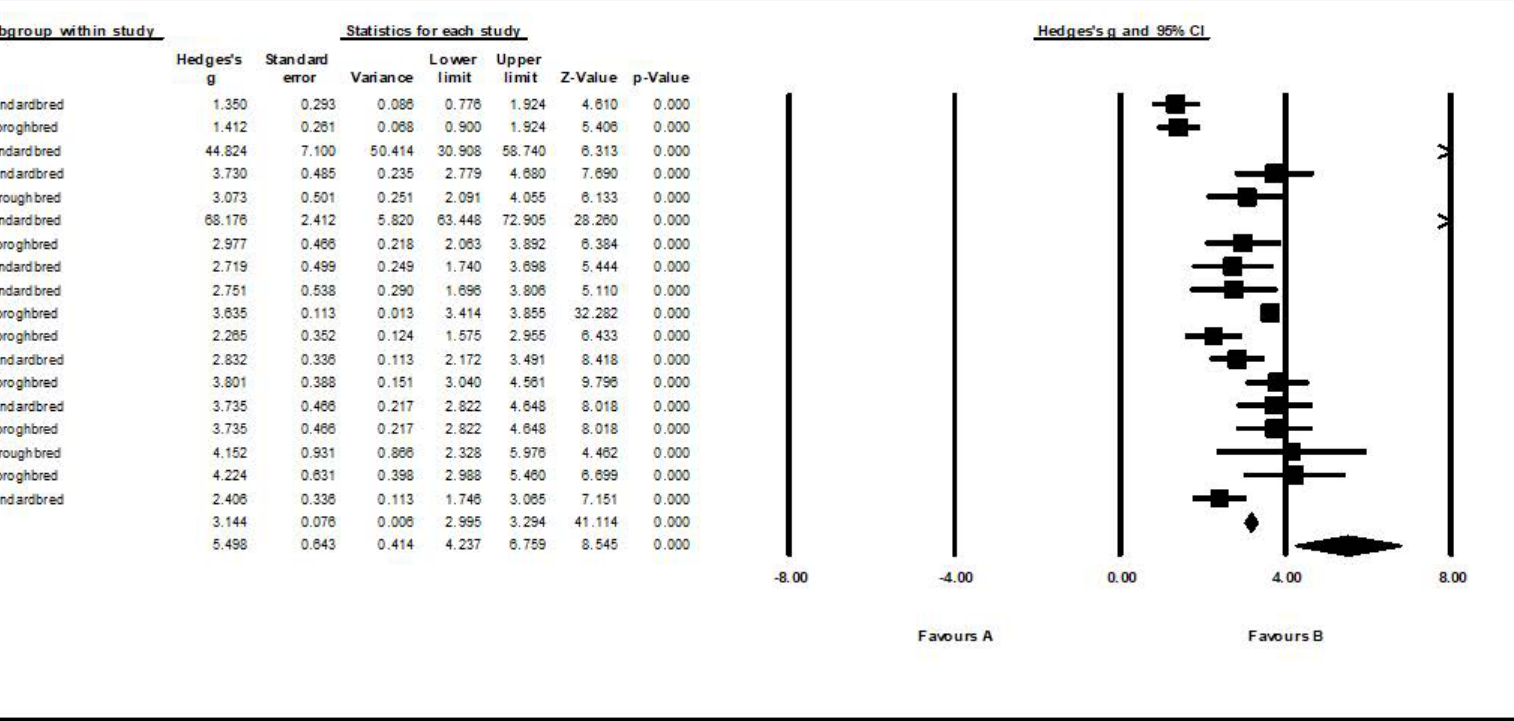
Figure 4. Forest plot for left ventricular free-wall (LVFW) thickness measurements in Thoroughbred and Standardbred horses. Studies and their respective citations: Al-Haidar et al., 2013 [35]; Al-Haidar et al., 2010 [2]; Bakos et al., 2002 [21]; Brown et al., 2003 [22]; Buhl et al., 2005 [18]; Collins et al., 2010 [36]; Grenacher and Schwarzwald, 2010 [37]; Kriz et al., 2000 [38]; Leadon et al., 1991 [23]; Long et al., 1992 [39]; Michima et al., 2004 [8]; Patteson et al.,1995 [6]; Pipers and Hamlin, 1977 [7]; Slater and Herrtage, 1995 [20]; Zucca et al., 2008